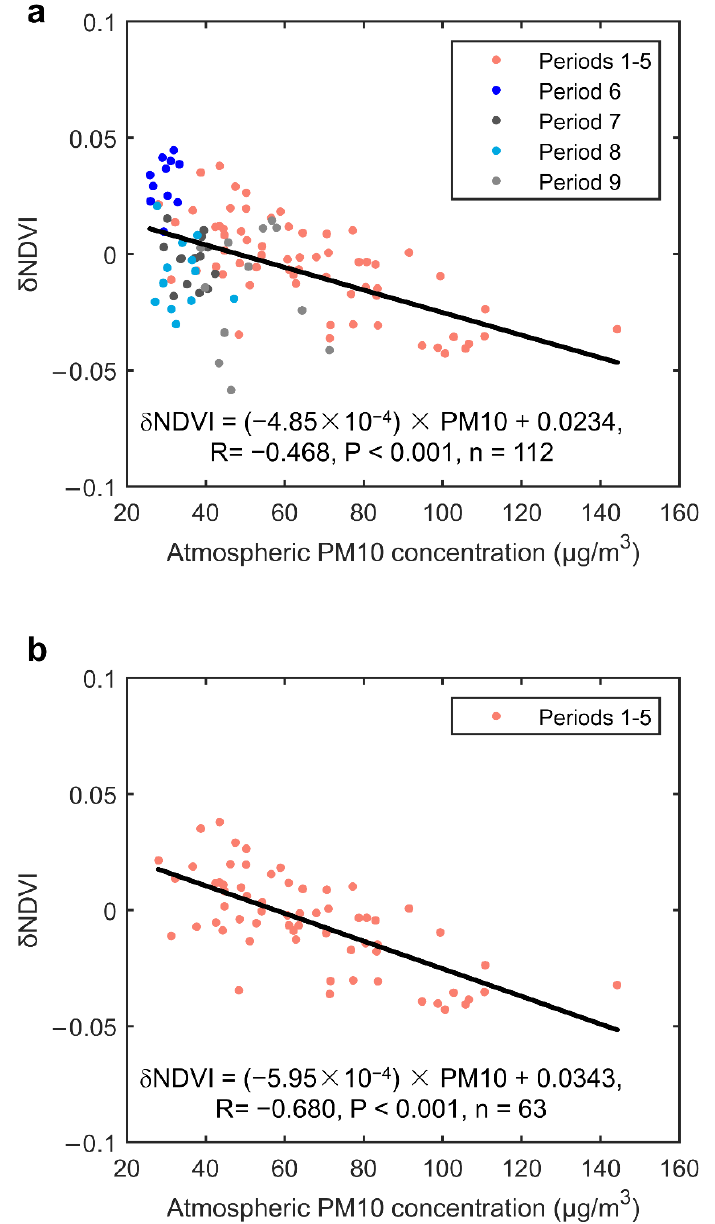
Figure 6. Scatter diagram of atmospheric PM10 concentration and the variation rate of the normal- ized difference vegetation index (δNDVI) at 14 stations over the study period, along with their fit- ting curves. ( a ). Points and fitted line of data from period 1 to 9 (black line, R = −0.468, n = 112, p < 0.001). This highlights the data pairs from period 6 (dark blue), period 7 (dark gray), period 8 (light blue), and period 9 (light gray), which deviate from the other data due to the influence of rainfall. A period refers to a time interval between two adjacent remote sensing observations. Note that data from period 8 and period 9 were influenced by uneven rainfall (See Figure 2 for specific data). ( b ). Points and fitted line of data from period 1 to 5 (salmon pink line, R = −0.680, n = 63, p < 0.001).